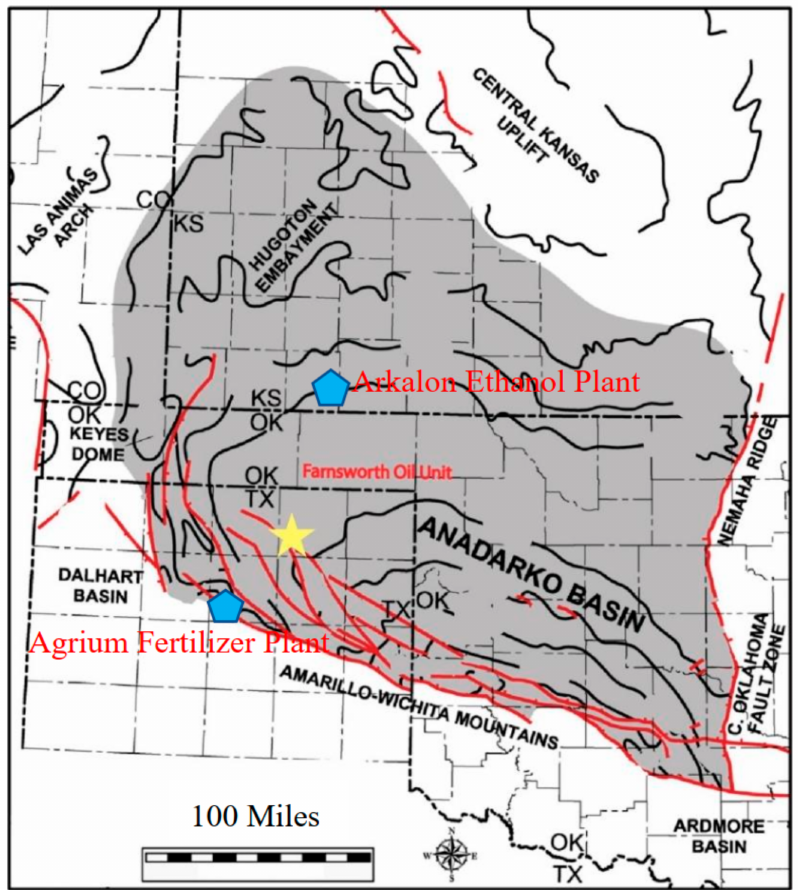
Figure 1. Location of the Farnsworth Unit (FWU) on the Northwest Shelf of the Anadarko Basin in West Texas. Red lines are approximate locations of faults that have been documented in the region. Blue pentagons indicate locations of Anthropogenic CO2